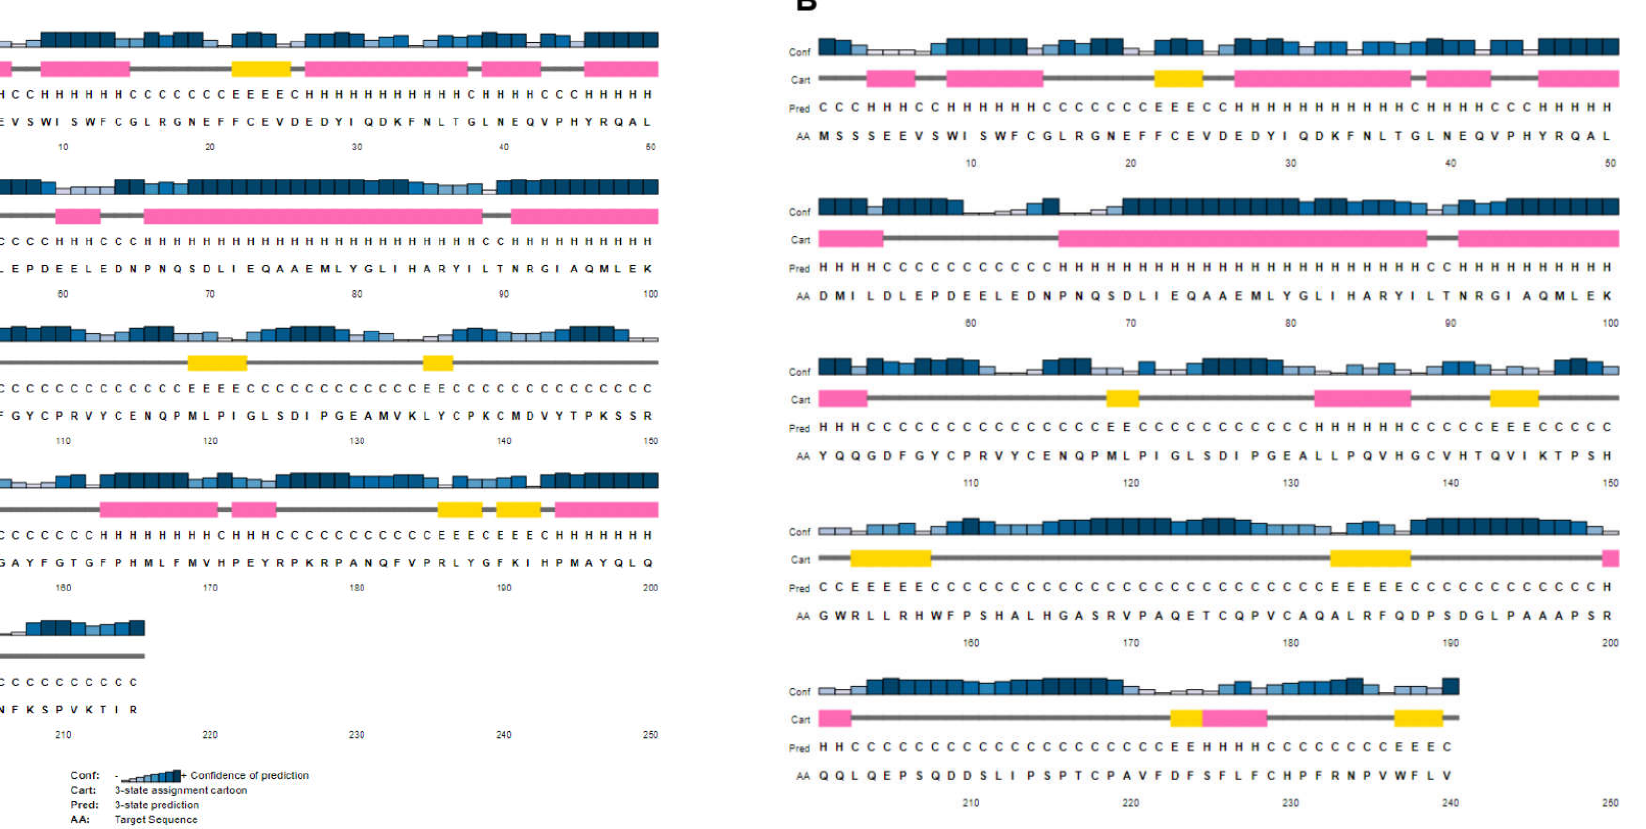
Figure 5. ( A ) Predicted secondary structure of the wild-type CK2beta and ( B ) of the predicted mutant elongated protein (p.Met132LeufsTer110) using PSIPRED Protein Analysis Workbench. The mutant is composed of new α-helices (pink) and strands (yellow); compare to the wild type in the predicted C-terminal tail of the mutant CK2beta protein (p.Met132LeufsTer110).